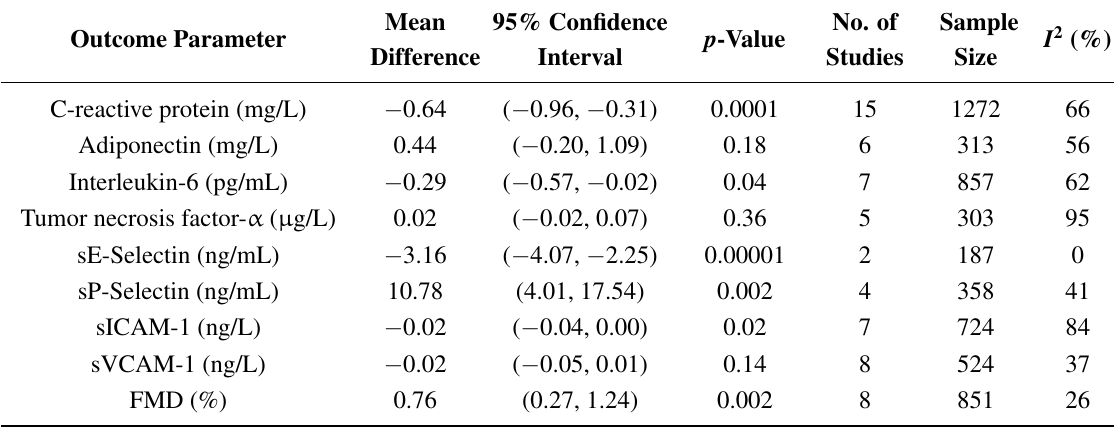
Table 2. Pooled estimates of effect size for the results of olive oil interventions compared to respective controls.